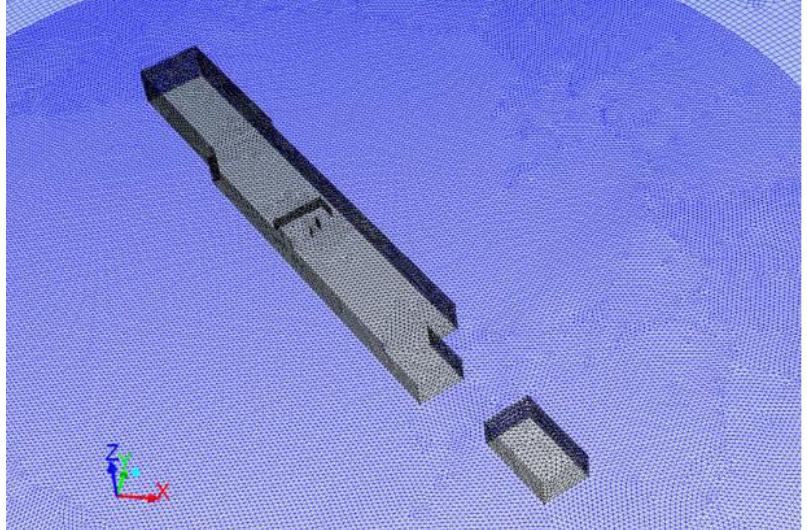
Figure 4. Surface meshes of buildings near ground in CFD model.